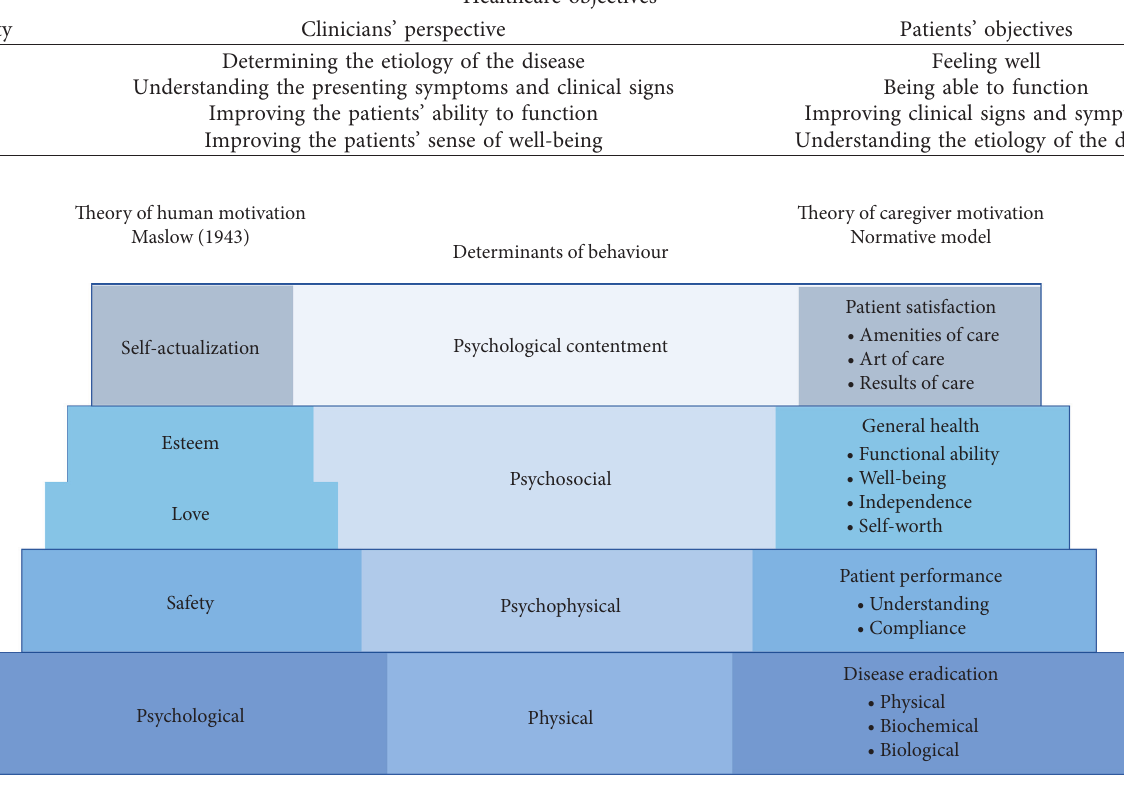
Figure 3: Human needs and patient outcomes construct (adapted from Maslow [63] and Johnson [64]).